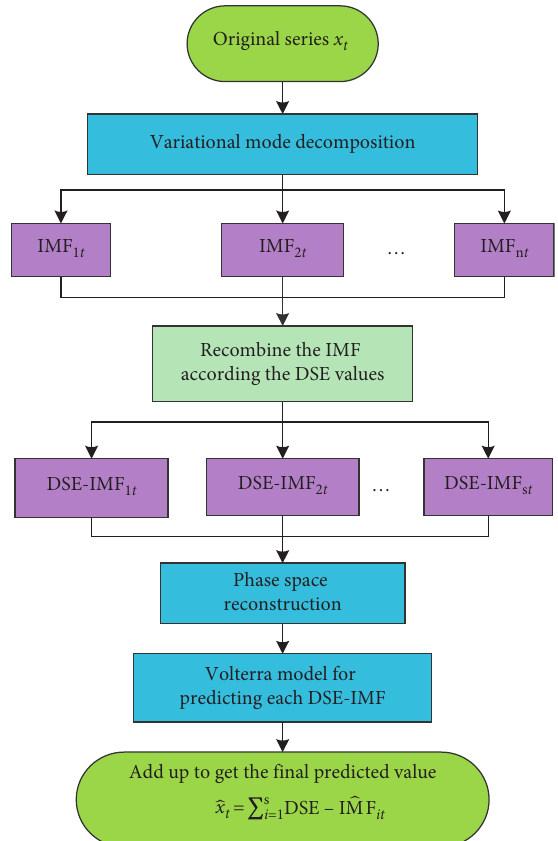
Figure 3: The flowchart of the VMD-DSE-Volterra